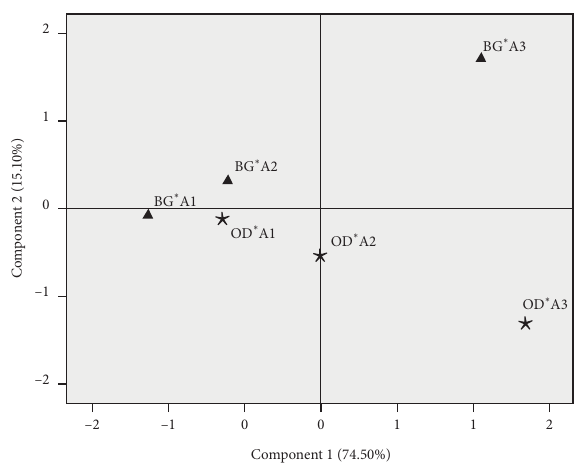
Figure 3: Two-dimensional principal component analysis plot for carcass traits, of Beni-Guil and Ouled-Djellal sheep, according to animals’ age (A) at slaughter; A1: six months to one year; A2: one to two years; A3: two to four the parameters of the meat colour (hue, lightness, and redness) and ultimate pH. It indicated that animals